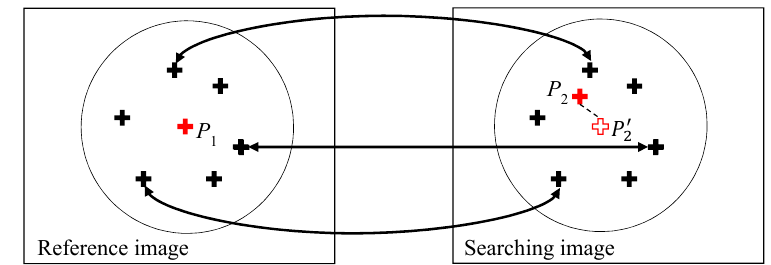
Figure 6. Local outlier elimination. ( P 1 , P 2 ) denotes the initial matches of the reference and sensed images. (cid:1842) (cid:2870)(cid:4593) is estimated from (cid:1842) (cid:2869) based on local polynomial coefficients.